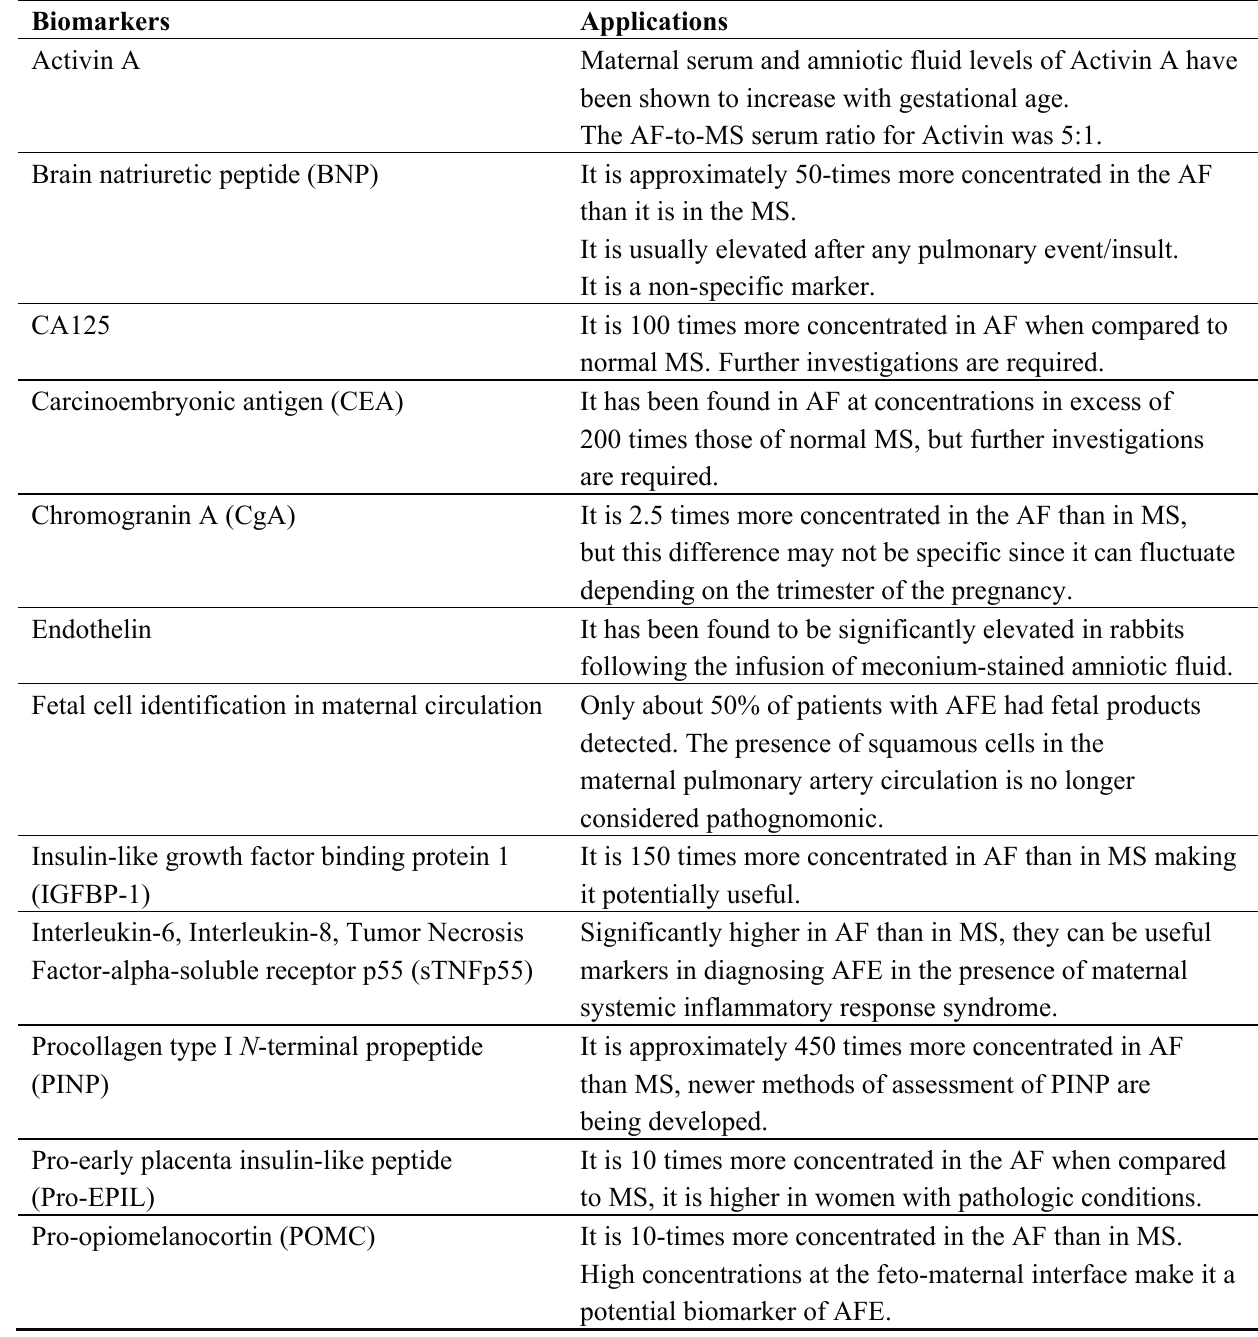
Table 1. Biomarkers potentially or presently available for the diagnosis of